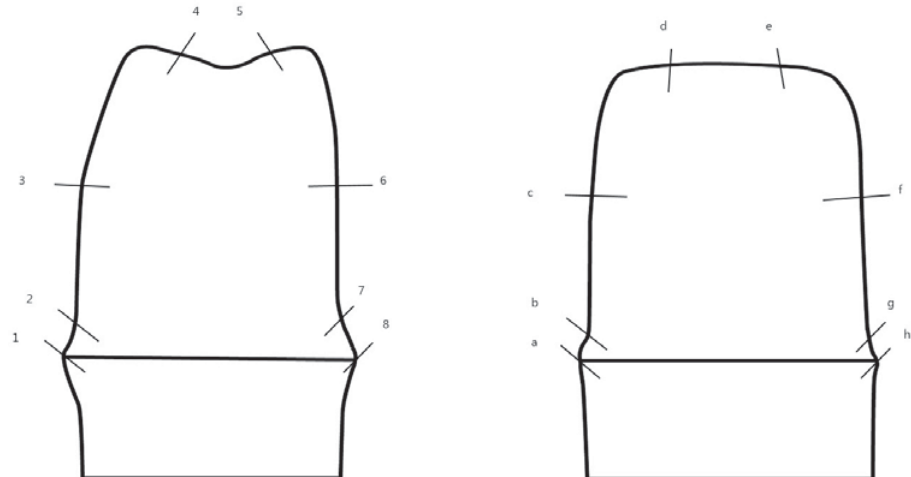
Figure 2- (cid:3)(cid:48)(cid:72)(cid:68)(cid:86)(cid:88)(cid:85)(cid:76)(cid:81)(cid:74)(cid:3)(cid:83)(cid:82)(cid:76)(cid:81)(cid:87)(cid:86)(cid:3)(cid:73)(cid:82)(cid:85)(cid:3)(cid:72)(cid:89)(cid:68)(cid:79)(cid:88)(cid:68)(cid:87)(cid:76)(cid:82)(cid:81)(cid:3)(cid:82)(cid:73)(cid:3)(cid:70)(cid:85)(cid:82)(cid:90)(cid:81)(cid:3)(cid:191)(cid:87)(cid:17)(cid:3)(cid:55)(cid:75)(cid:72)(cid:3)(cid:83)(cid:82)(cid:76)(cid:81)(cid:87)(cid:86)(cid:3)(cid:20)(cid:3)(cid:87)(cid:82)(cid:3)(cid:27)(cid:3)(cid:68)(cid:85)(cid:72)(cid:3)(cid:83)(cid:82)(cid:86)(cid:76)(cid:87)(cid:76)(cid:82)(cid:81)(cid:72)(cid:71)(cid:3)(cid:82)(cid:81)(cid:3)(cid:87)(cid:75)(cid:72)(cid:3)(cid:69)(cid:88)(cid:70)(cid:70)(cid:82)(cid:79)(cid:76)(cid:81)(cid:74)(cid:88)(cid:68)(cid:79)(cid:79)(cid:92)(cid:3)(cid:86)(cid:72)(cid:70)(cid:87)(cid:76)(cid:82)(cid:81)(cid:72)(cid:71)(cid:3) surface, and a to h are on the mesiodistally sectioned surface. Points of 1, 8, a, h are positioned on the margin, 2, 7, b, g are on the lower axial wall, 3, 6, c, f are on the upper axial wall, and 4, 5, d, e are on the occlusal